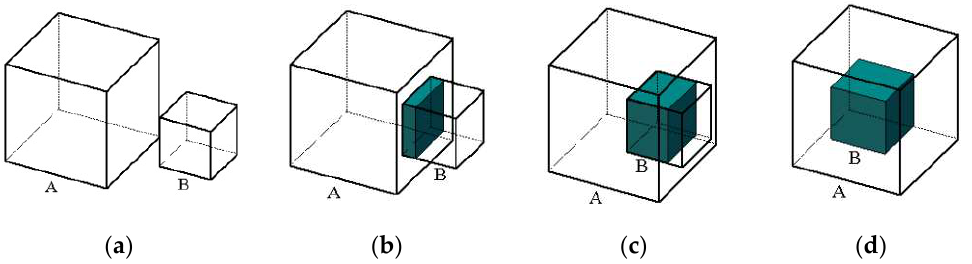
Figure 4. Different situations of object intersection: ( a ) no intersection; ( b ) tiny intersection; ( c ) large intersection; ( d ) fully intersection.